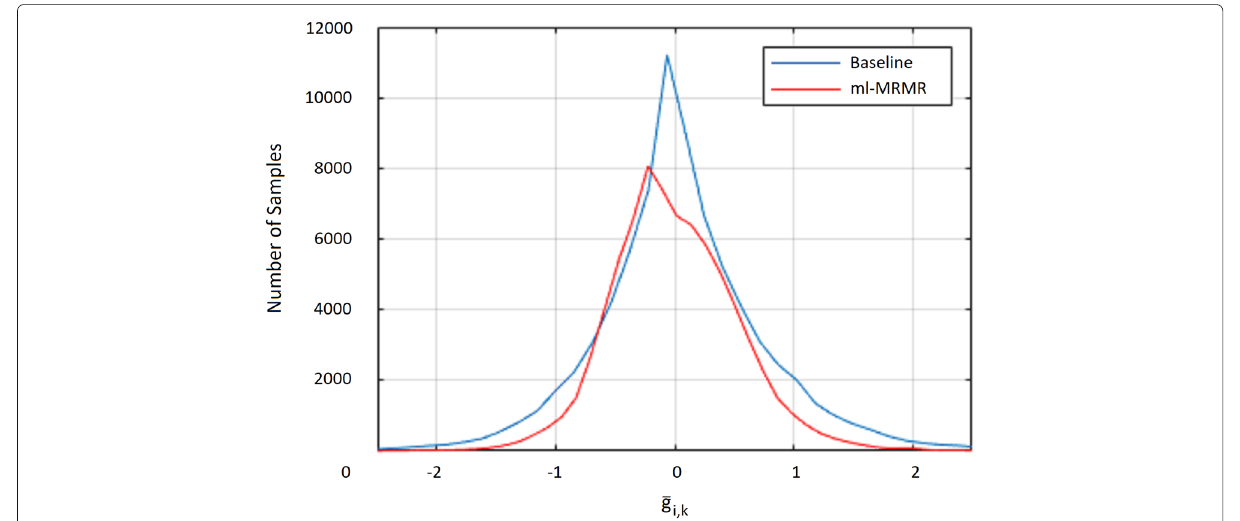
Fig. 2 Comparison of the distributions of ¯ g i , k for the baseline MRMR and the proposed ml-MRMR algorithms. Turkish database is used